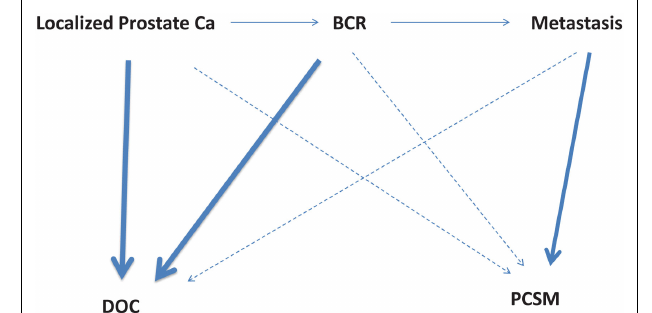
FIGURE 1 | Disease states of localized prostate cancer patients and their likelihood of mortality from either other causes (DOC, death of other causes) or prostate cancer (PCSM, prostate cancer specific mortality). The bold lines indicate a higher risk of mortality, while the dotted lines indicate a lower risk of mortality. BCR, biochemical recurrence; PCSM, prostate cancer specific mortality; DOC, death of other causes.